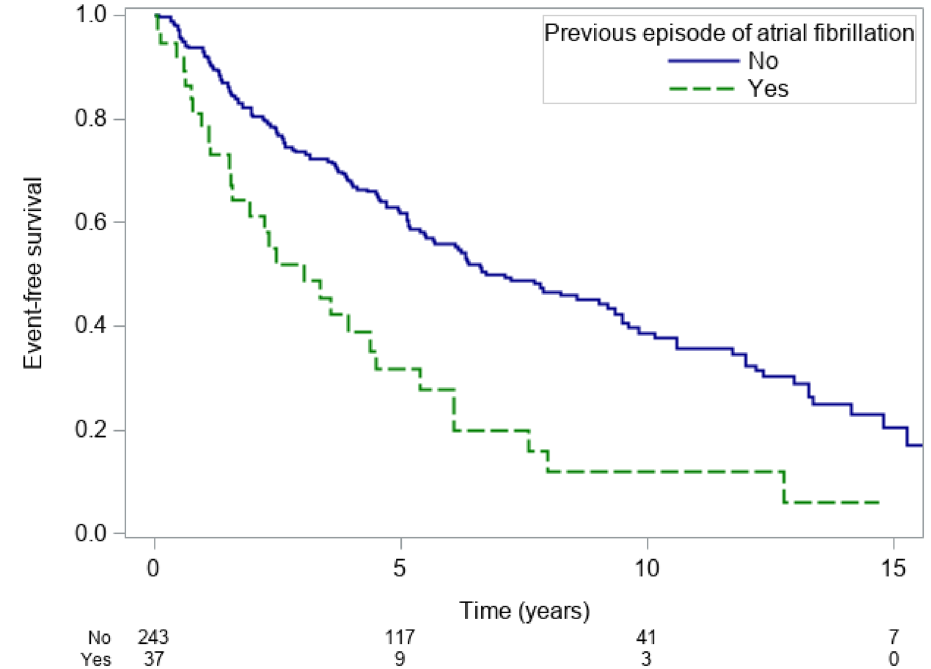
Figure 2. Kaplan–Meier event-free survival estimates for patients with previous AF (green line) and no previous AF (blue line). AF atrial fibrillation.